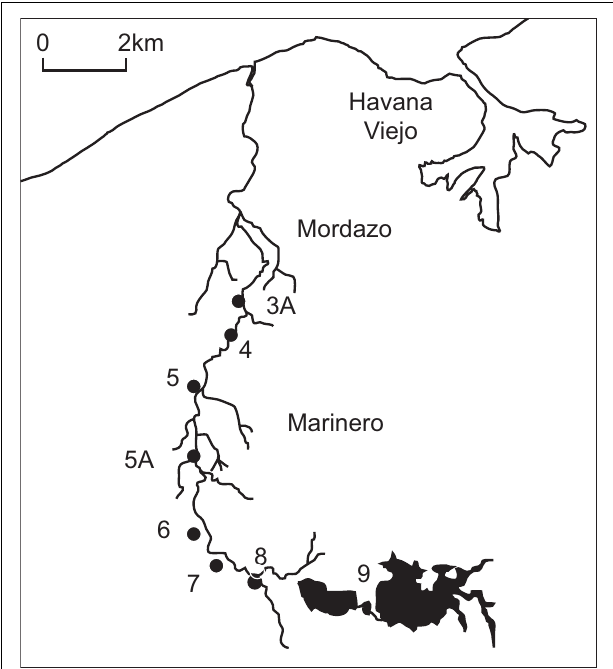
FIGURE 1 | Map of theAlmendares River and sampling locations in western